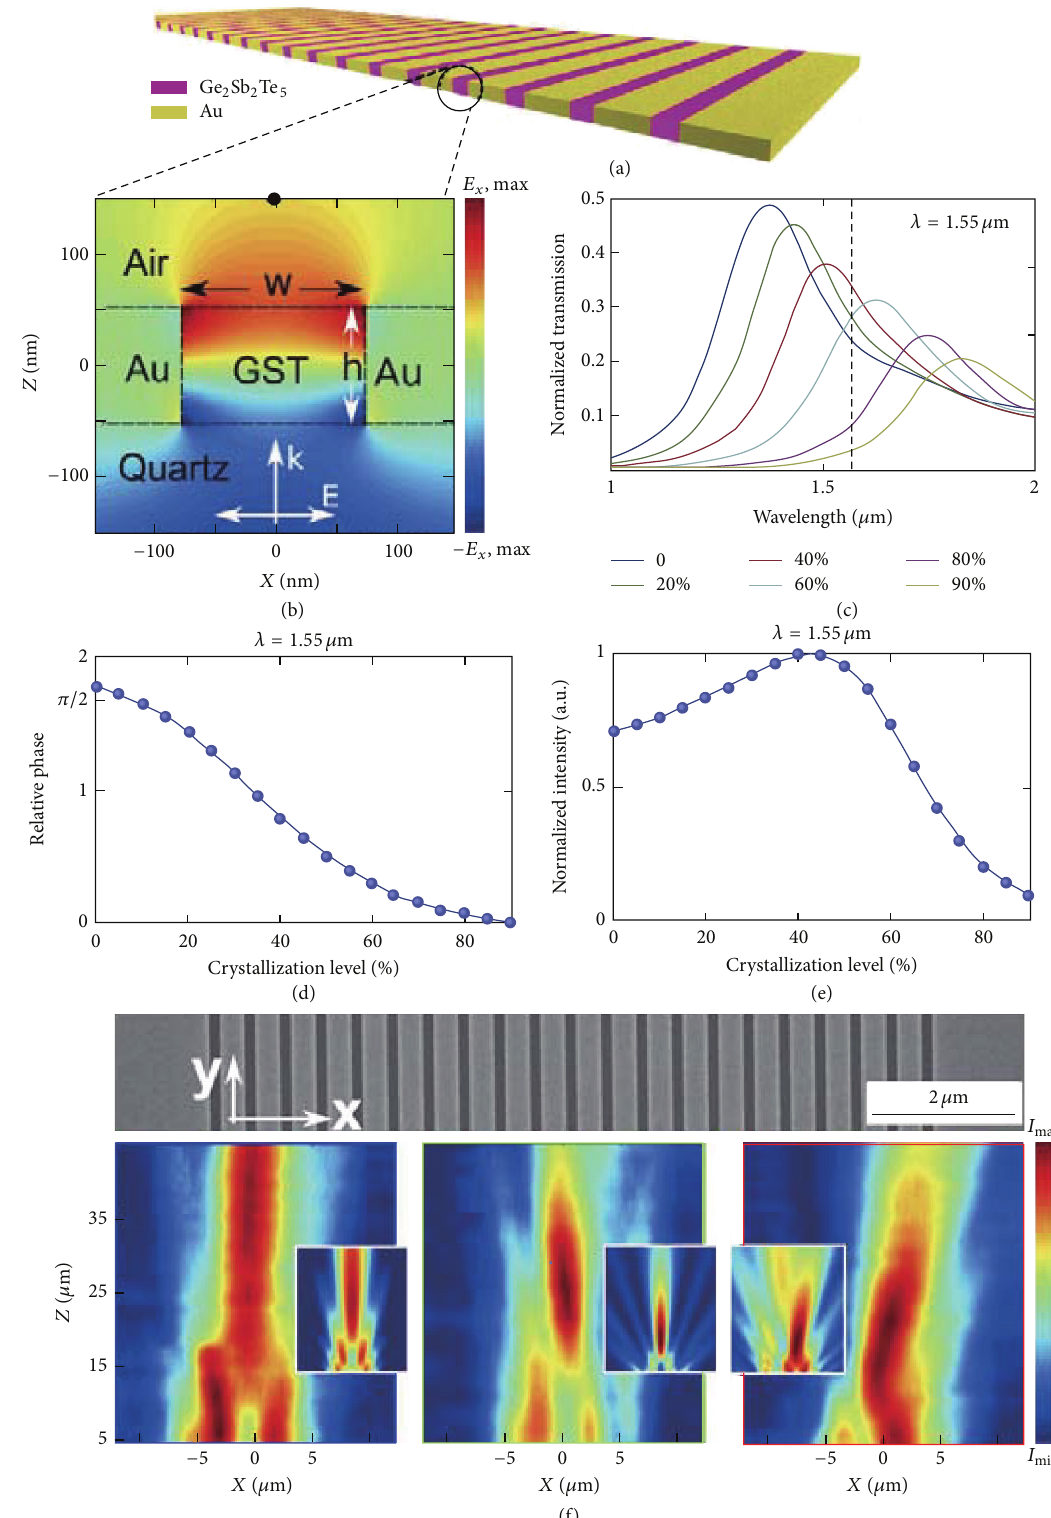
Figure 22: (a) Schematic diagram of the planar lens. (b) The cross section showing the 𝑥 -component of the electric field of the 1st-order mode from a single slit. (c) The evolution of the single-slit transmission spectrum for different crystallization levels. (d) The relative phase and (e) the normalized electric field intensity at 1.55 𝜇 m as functions of the crystallization level with a 5% step increment. (f) Focusing pattern measured in 𝑥𝑧 -plane by confocal scanning optical microscopy for different status of GST. Figures are reproduced from